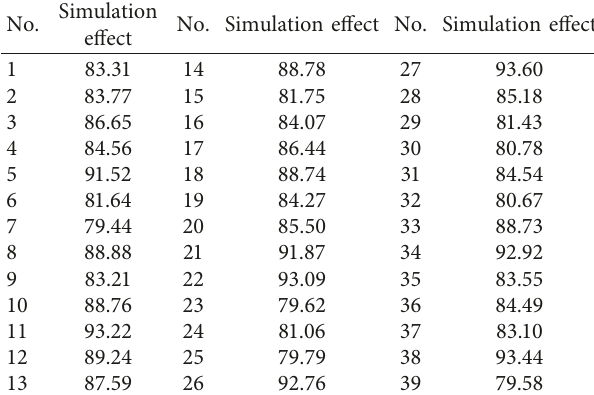
Table 3: Simulation results of air traffic flow management model of civil aviation based on spatial data